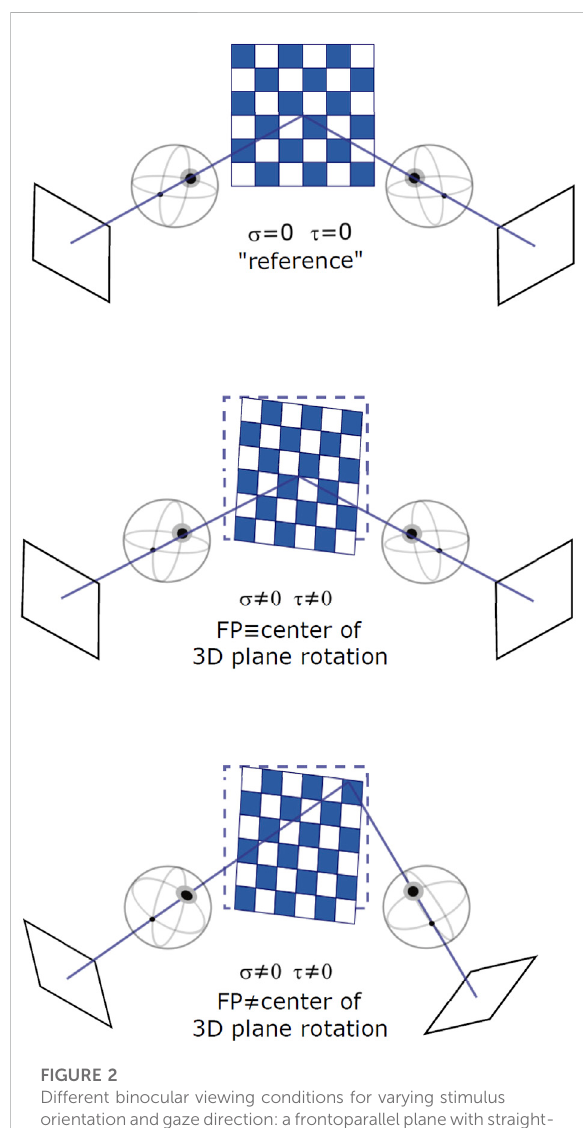
FIGURE 2 Different binocular viewing conditions for varying stimulus orientationandgazedirection:afrontoparallelplanewithstraight- ahead gaze (top), a slanted plane with straight-ahead gaze (middle), and a slanted plane with eccentric gaze (bottom). Slant and tilt of the plane are expressed as rotations around a fi xed [ X , Y , Z ] world reference